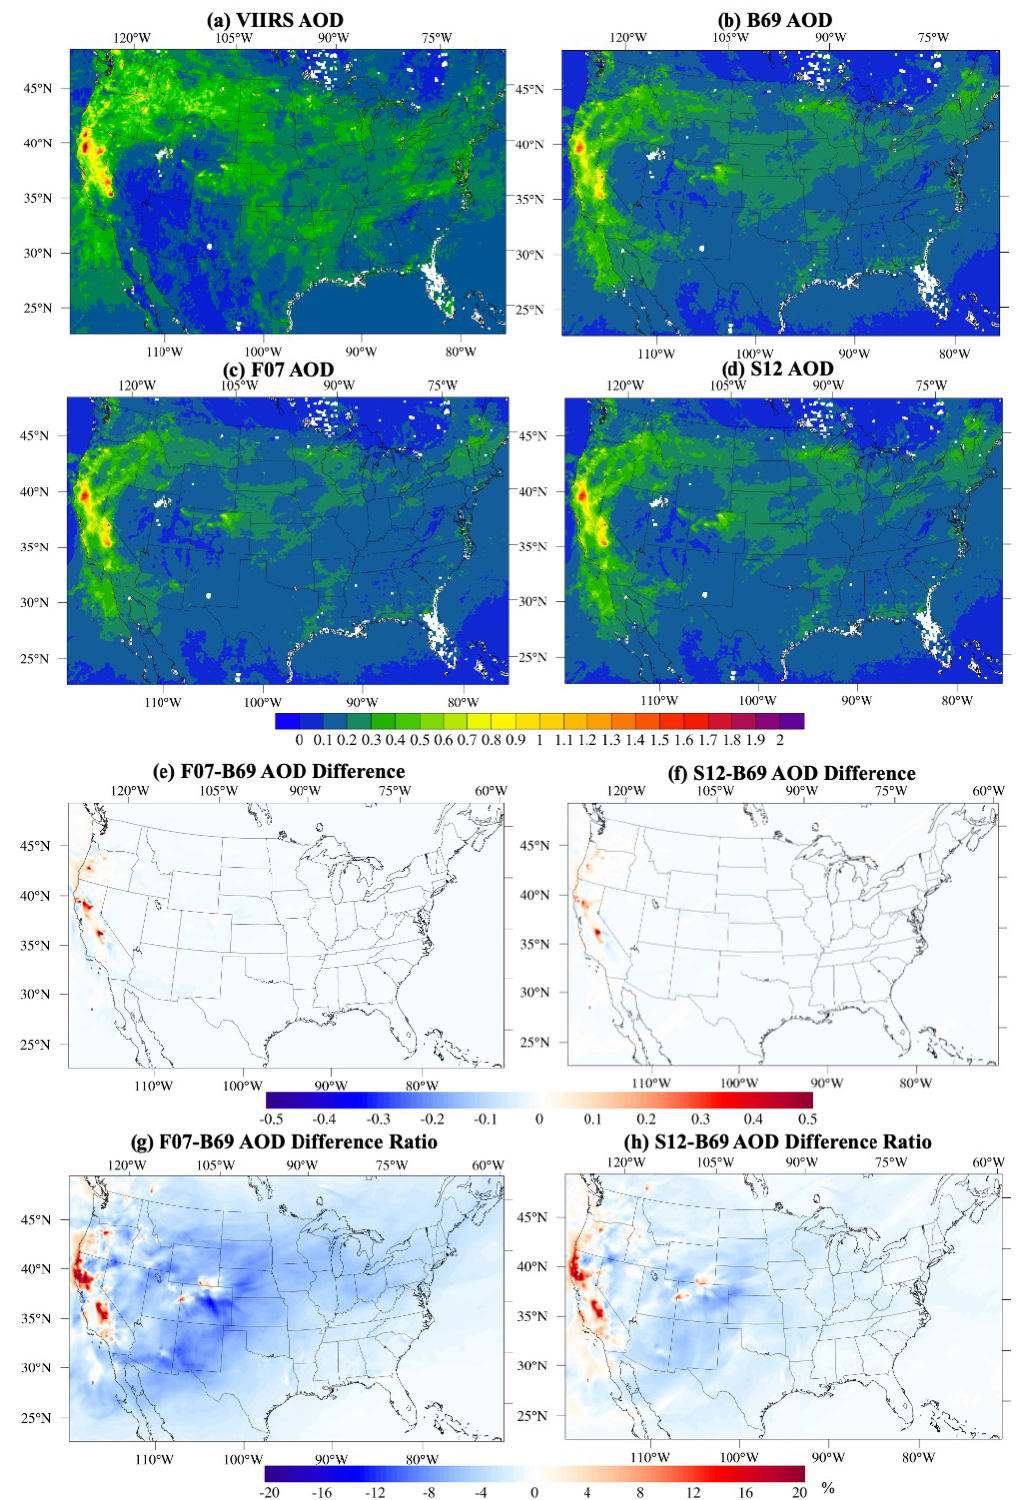
Figure 8. The 2-month average AOD from VIIRS (a) , B69 run (b) , F07 run (c) , and S12 run (d) from 1 August to 30 September 2020. The average AOD differences between F07 and B69 (e) and between S12 and B69 (f) during the same period as in panel (a) . The average AOD difference ratio between F07 and B69 (g) and between S12 and B69 (h) during the same period as in panel (a)